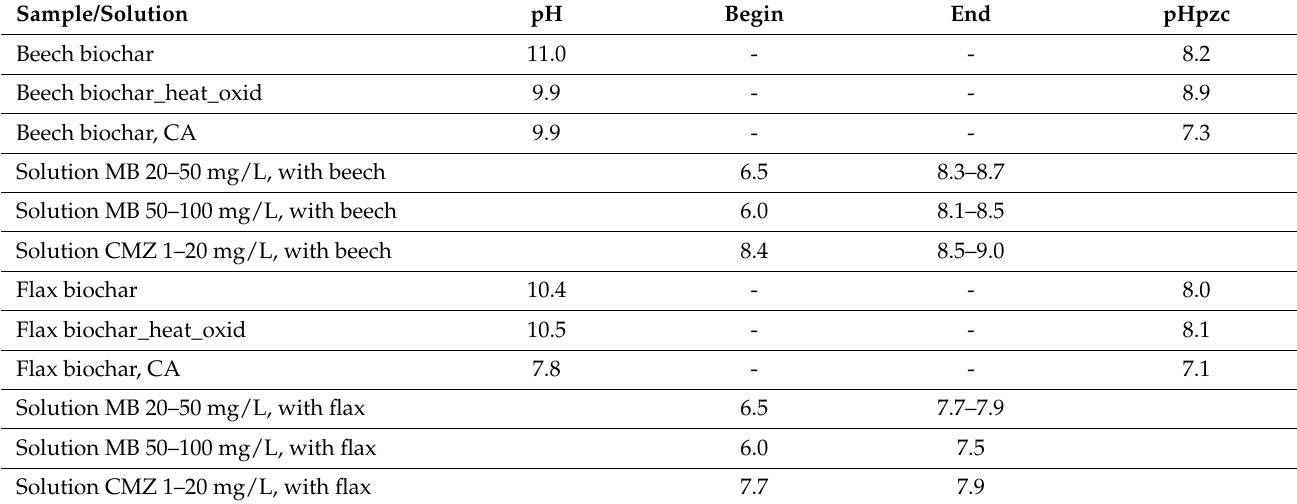
Table 6. Values of pH for the biochars, evolution of the pH value at the beginning and at the end of the experiments, biochar charge 0.1 g/100 mL solution, and values of pH at the point of zero